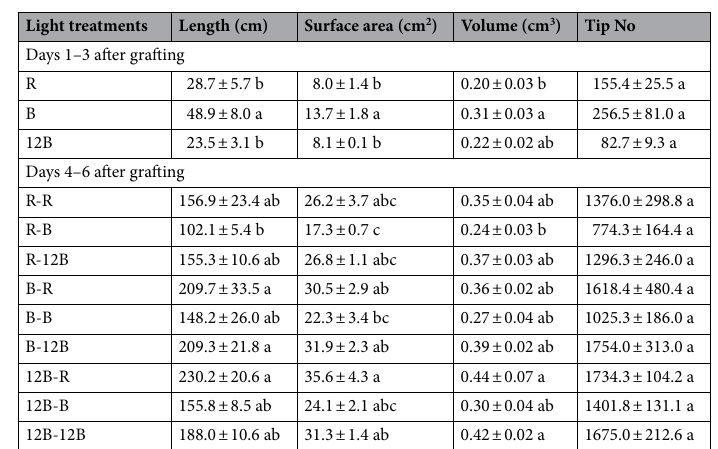
Table 2. Root architecture parameters of grafted watermelon seedlings analyzed with WinRHIZO root- scanning system after three or six days in the healing chamber under three or nine light treatments, respectively. Mean values (± SE) within a column followed by different letters indicate significant differences (a < 0.05). Mean values derived from n = 6 scanned roots.